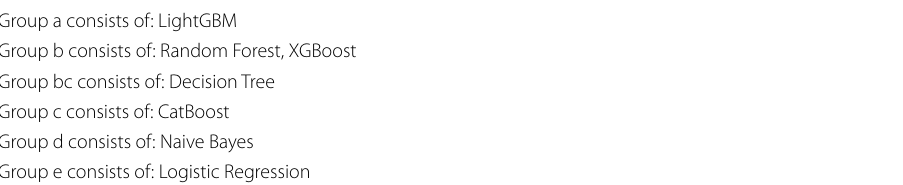
Table 17 HSD groupings of classifiers after 2-factor ANOVA where classifier and sampling ratio are factors; groups are by performance in terms of AUC